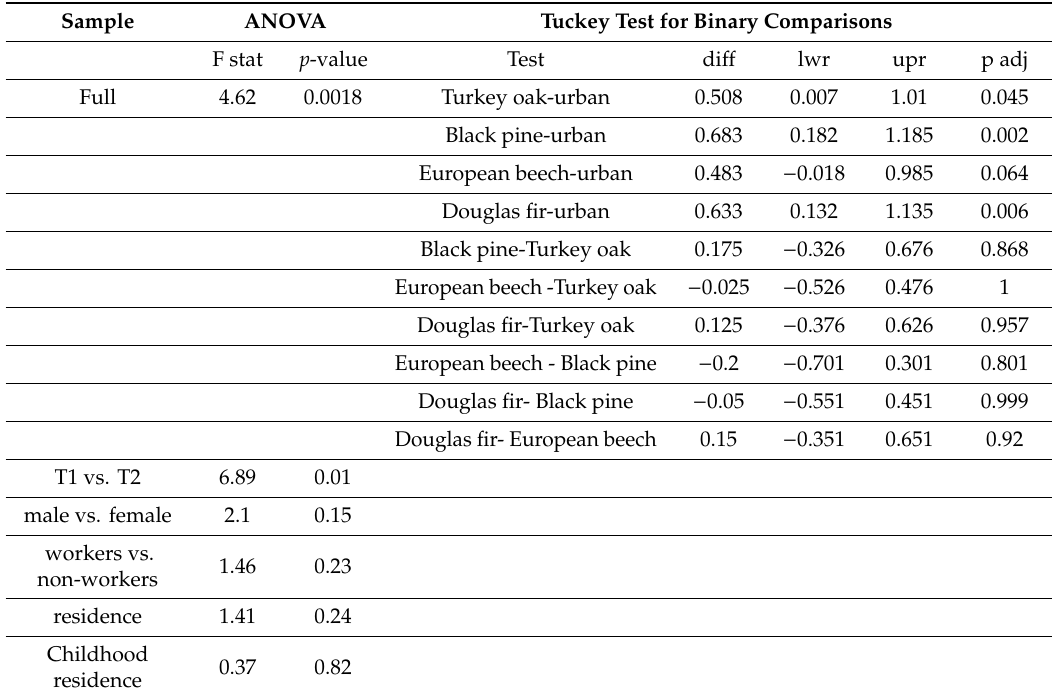
Table 4. ANOVA and Tuckey tests for di ff erences in the ROS answers among the treatments. Sample